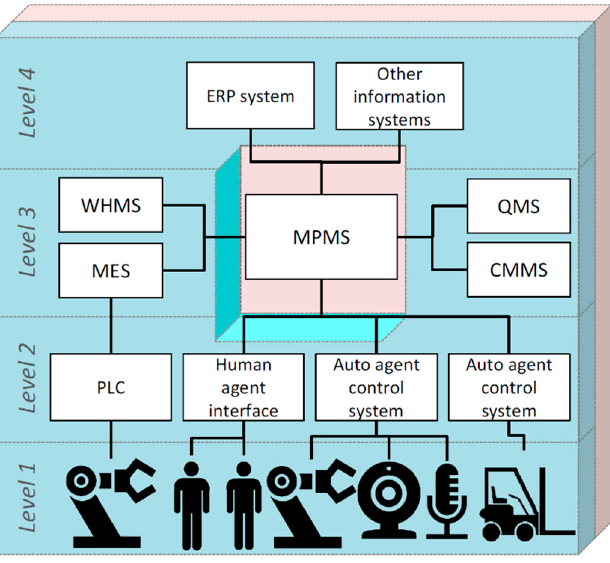
Figure 11. MPMS in the context of unified business process management [48].